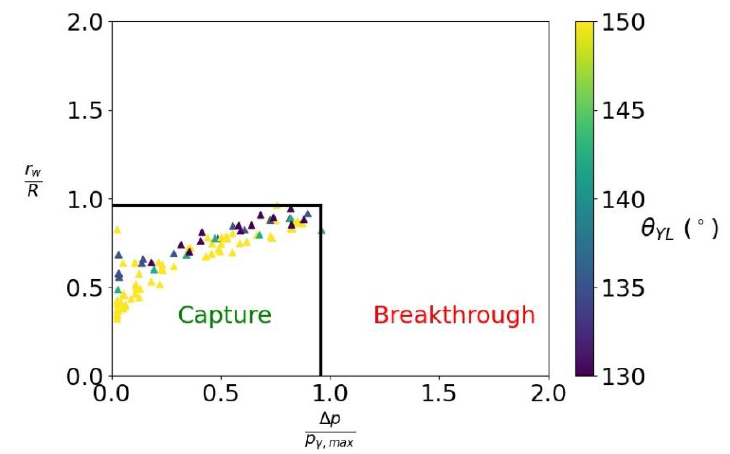
Figure 20. Droplet deformation versus the normalized pressure.